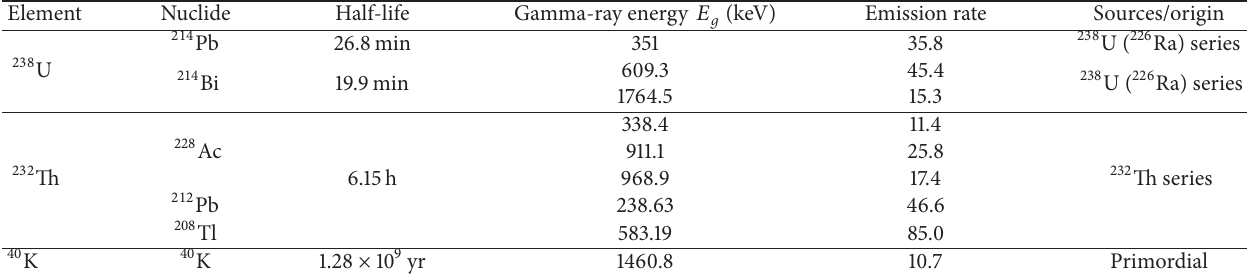
Table 1: Gamma-ray energy and emission rate for 238 U, 232 Th, and 40 K